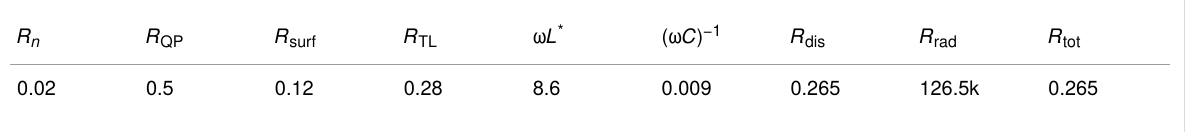
Table 1: Estimation of characteristic resistances (in ohms) for a Nb/AlO x /Nb tunnel junction with sizes a = 100 μ m, b = 10 μ m, d = 2 nm,